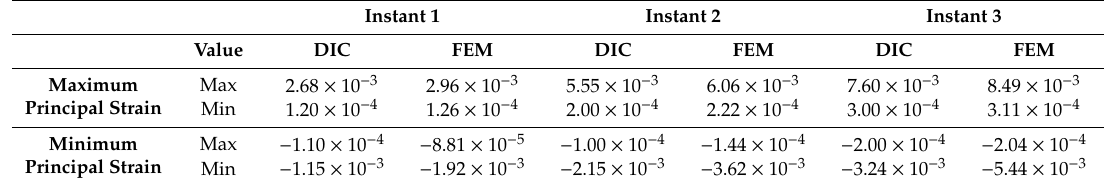
Table 7. Maximum and minimum strain values for geometry A.